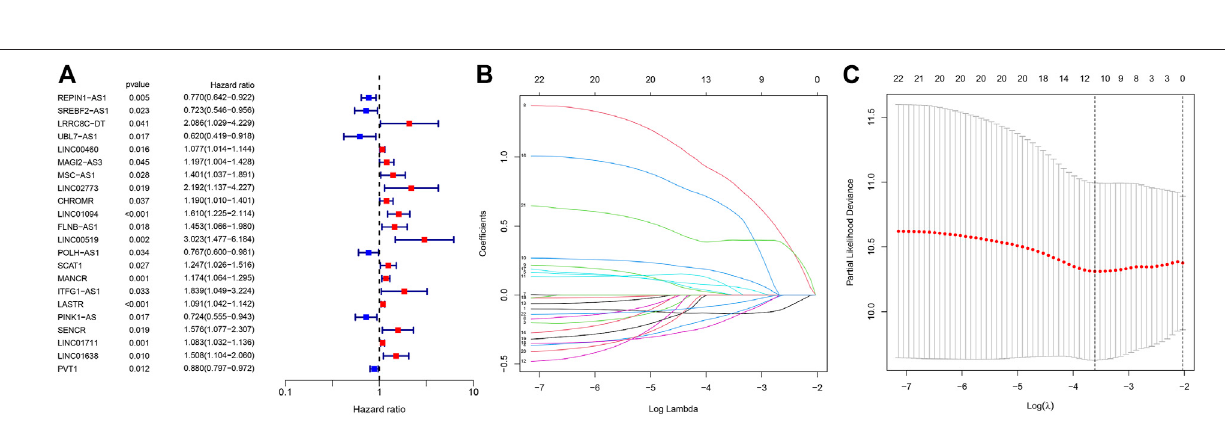
Frontiers in Genetics |